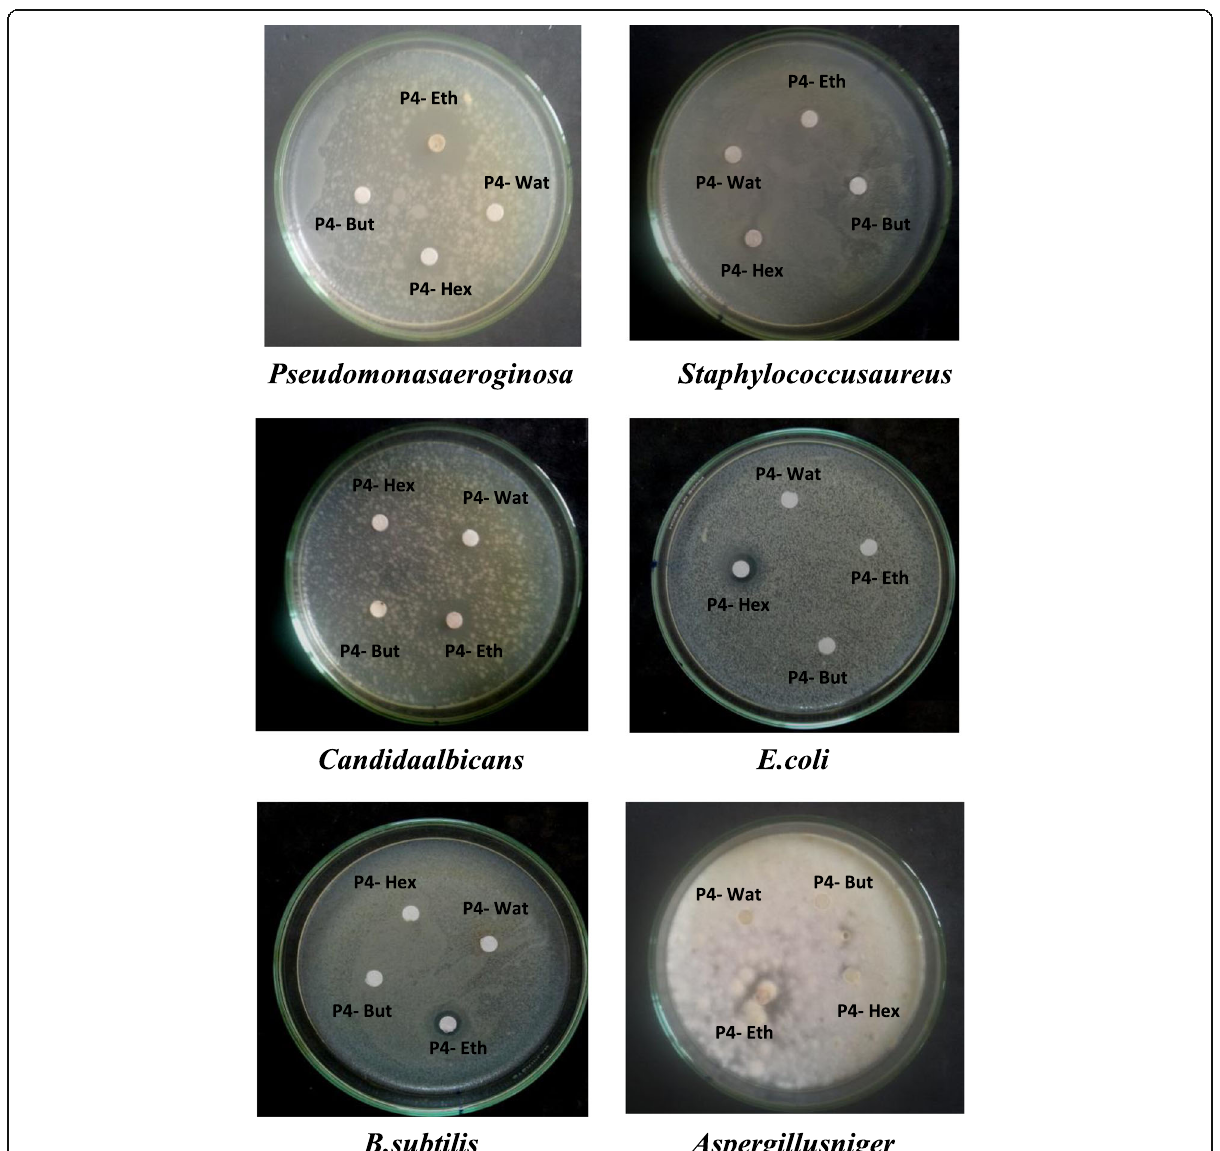
Fig. 5 Clear zone of Streptomyces sp. MER4(P4) subfractions using disc diffusion method with different test